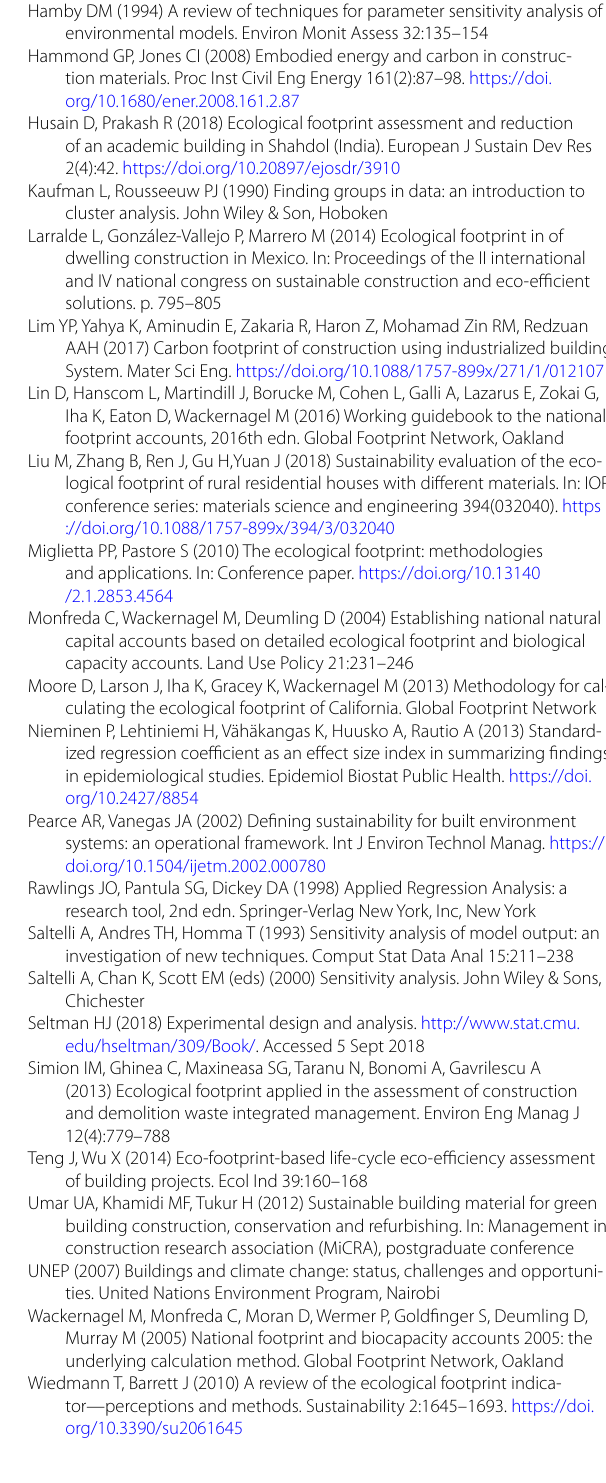
Table 8 Crops produced in 2014 and consumed land area for the production were adopted from CSA